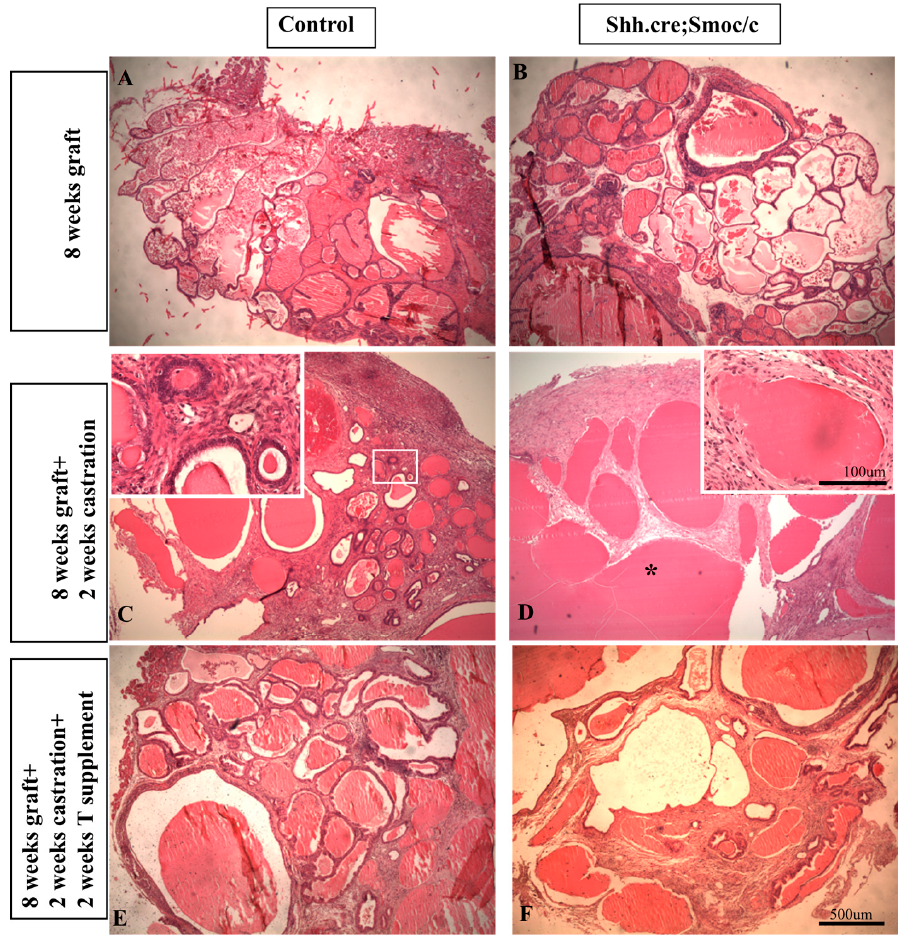
Figure 4. In vivo subcapsular grafts of P1 UGS from control and Shh cre ; Smo c/c mutants . Histologic appearance after eight weeks growth (top), two weeks after castration (middle) and two weeks after testosterone supplement. n = 3.